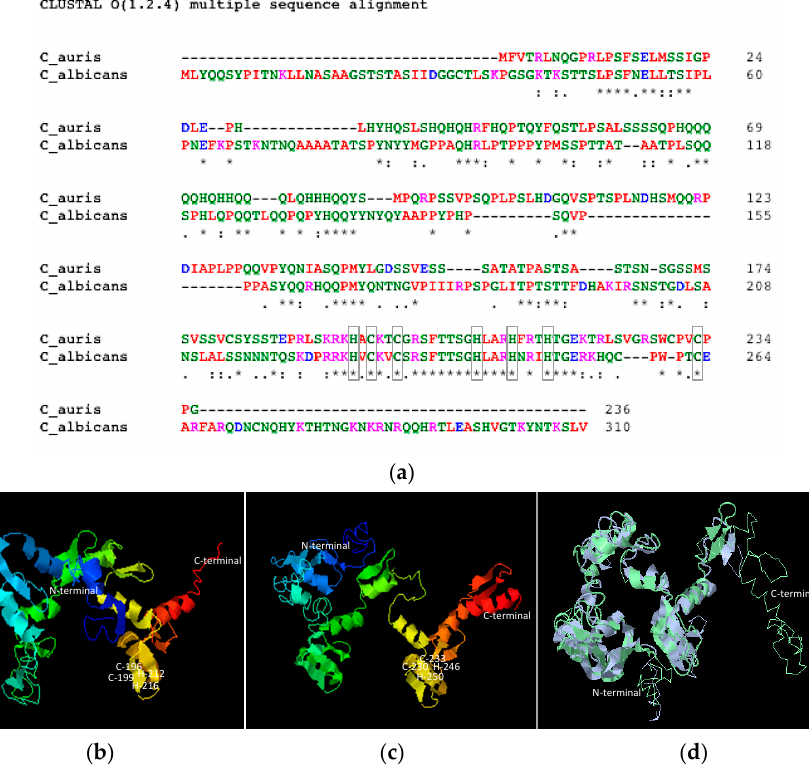
Figure 3. Comparison between Nrg1p of C. auris and C. albicans . Alignment of amino acid sequences of Nrg1p of C. auris and C. albicans ( a ). The Cys and His residues (C 2 H 2 zinc-finger) and the identities between the amino acid residues are marked by gray boxes and asterisks, respectively. Predicted 3D structures of Nrg1p of C. auris ( b ) and C. albicans ( c ) using Iterative Threading ASSEmbly Refinement (I-TASSER). N-terminus, C-terminus and predicted zinc-binding domains are marked. ( d ) Structure alignment of C. auris Nrg1p (purple) and C. albicans Nrg1p (green) using predicted structures from I-TASSER. Note C. auris lacks 44 residues after the C 2 H 2 zinc-finger domain (Class 1) at its C-terminus. The aligned image was tilted forward for better viewing, and hence the N-terminal regions appear different from images ( b , c ).